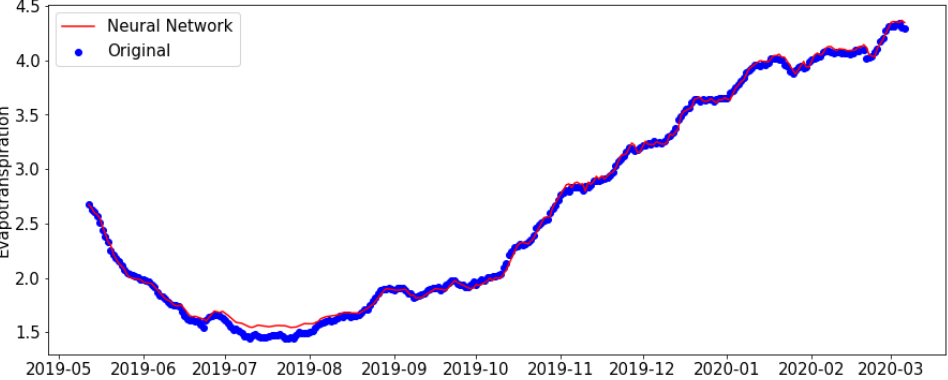
Figure 6. Comparison of the 300-day ETo prediction using a neural network with the actual data (Direct approach).